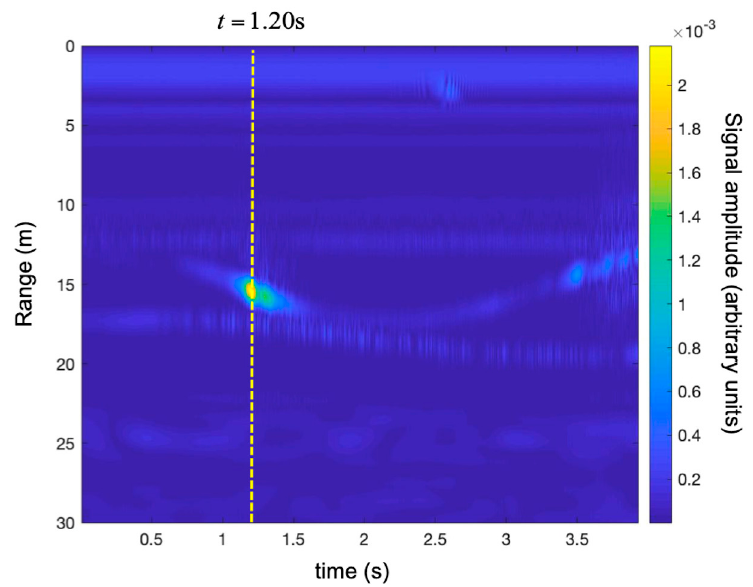
Figure 20. Maneuver 1 (i.e., take-off and rapid running away). Range plots at time t = 4.92 without the Doppler correction ( in red ) and with the Doppler correction ( in green ).